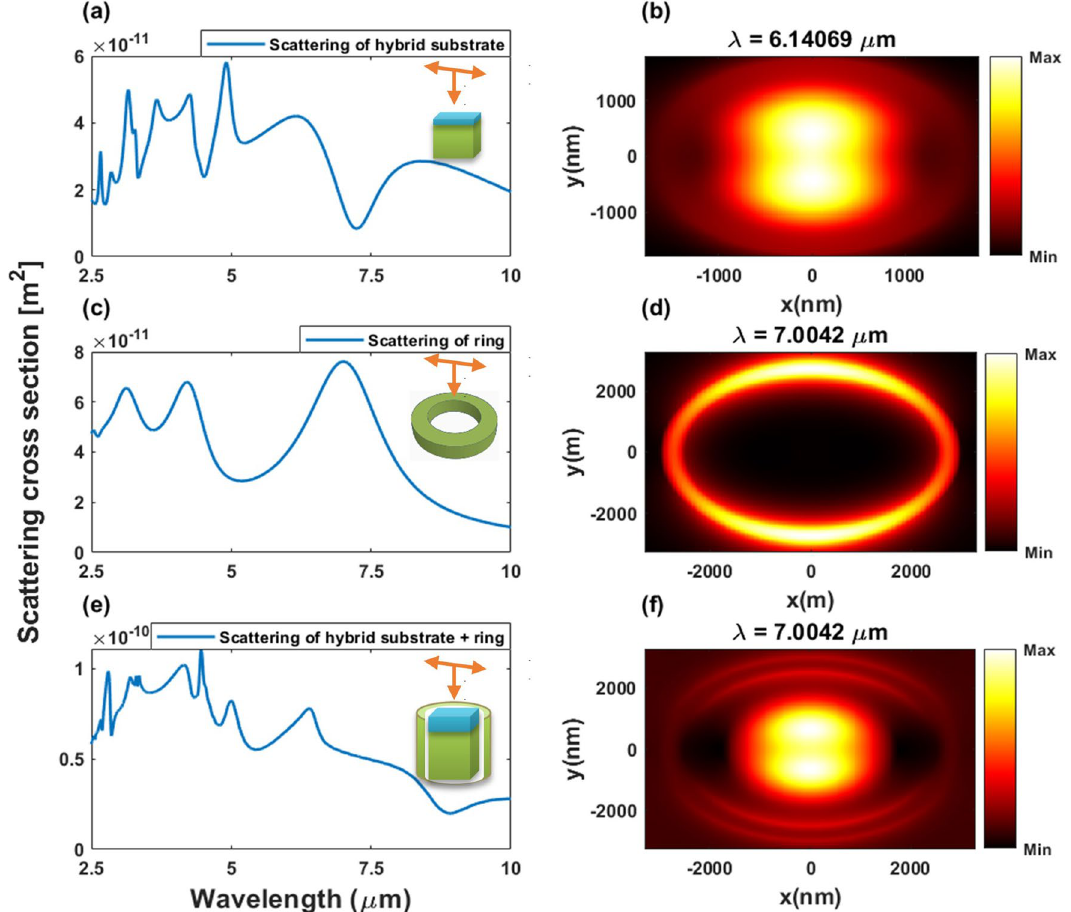
Figure 14. Optical responses of the hyrid substrate, ring, and the coupled system. ( a , c , e ) are the scatterin spectrums of the individual hybrid substarte, the individual ring, and the coupled system. The schematic of the structure with TFSF excitation is shown in the bottom inset. ( b , d , f ) are the corresponding magnetic field distribution on the x–y